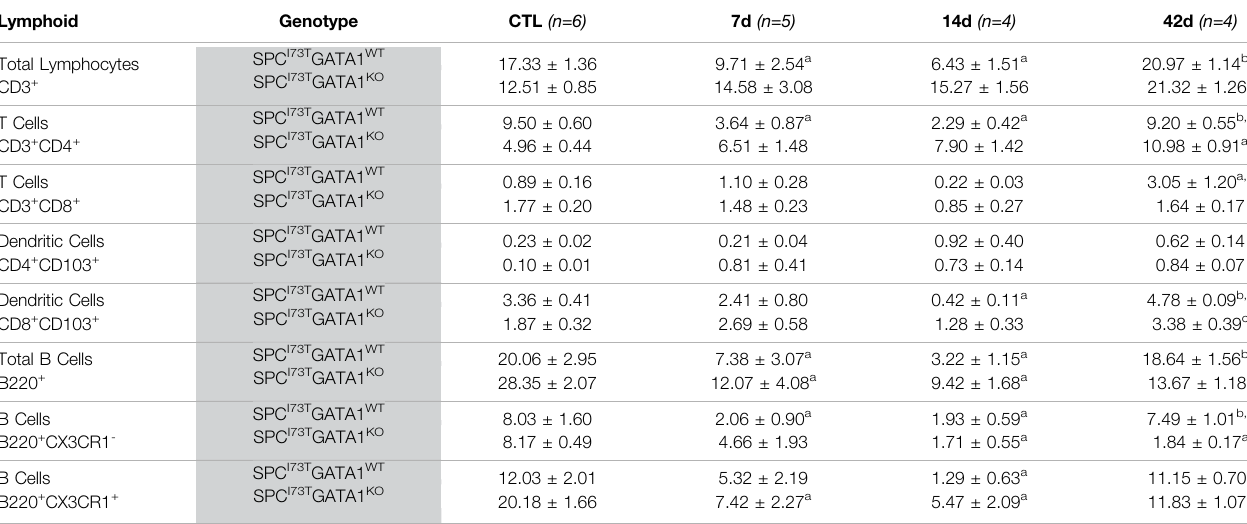
TABLE 4 | Lymphoid populations (relative abundance) in the lung of SP-C I73T GATA1 WT and SP-C I73T GATA1 KO mice.